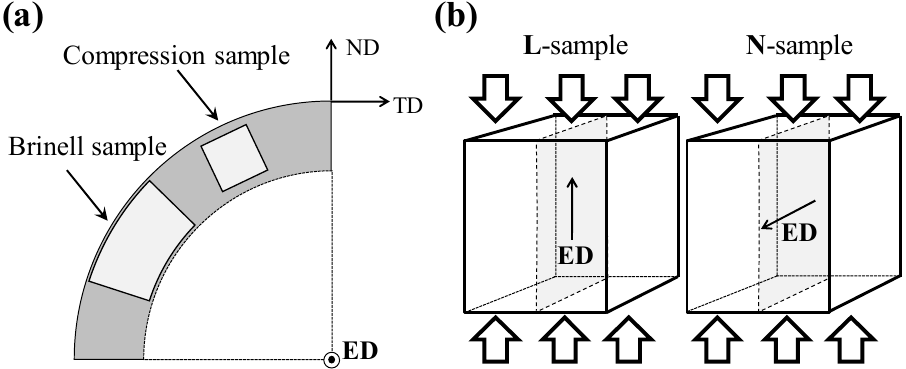
Figure 1. ( a ) Position of machined simples in the wall thickness of PM2000 tube, and reference system for further EBSD measurements; ( b ) relative position of deformation direction to extrusion direction (ED) in compression tests.